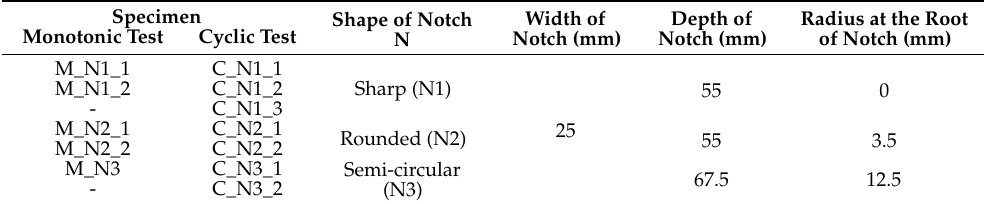
Table 2. Description of test